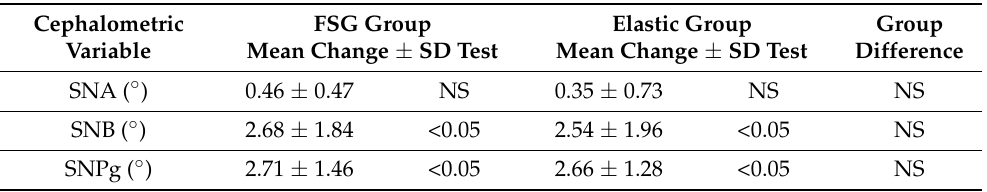
Table 1. The mean changes within each group and comparison between both